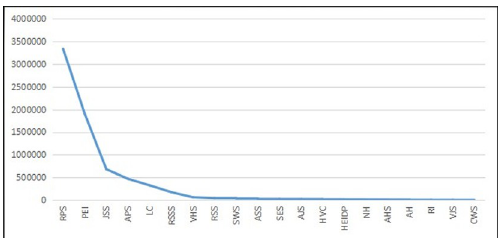
Fig 1. The distribution curve of school numbers for different education categories in China from 2003–2014 (Unit: Quantity). Data source are the Ministry of Education of the People’s Republic of China and the Statistical Yearbook of China’s Educational Expenditure from 2003–2014 . Drawn by STATA 15.0 and Excel 2017. The same below (if no extra description). RPS is Regular Primary Schools. PEI is Preschool Education Institutions. JSS is